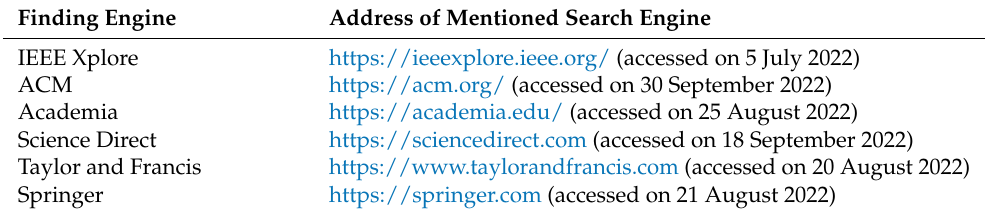
Table 1. Selection of search engine. Finding